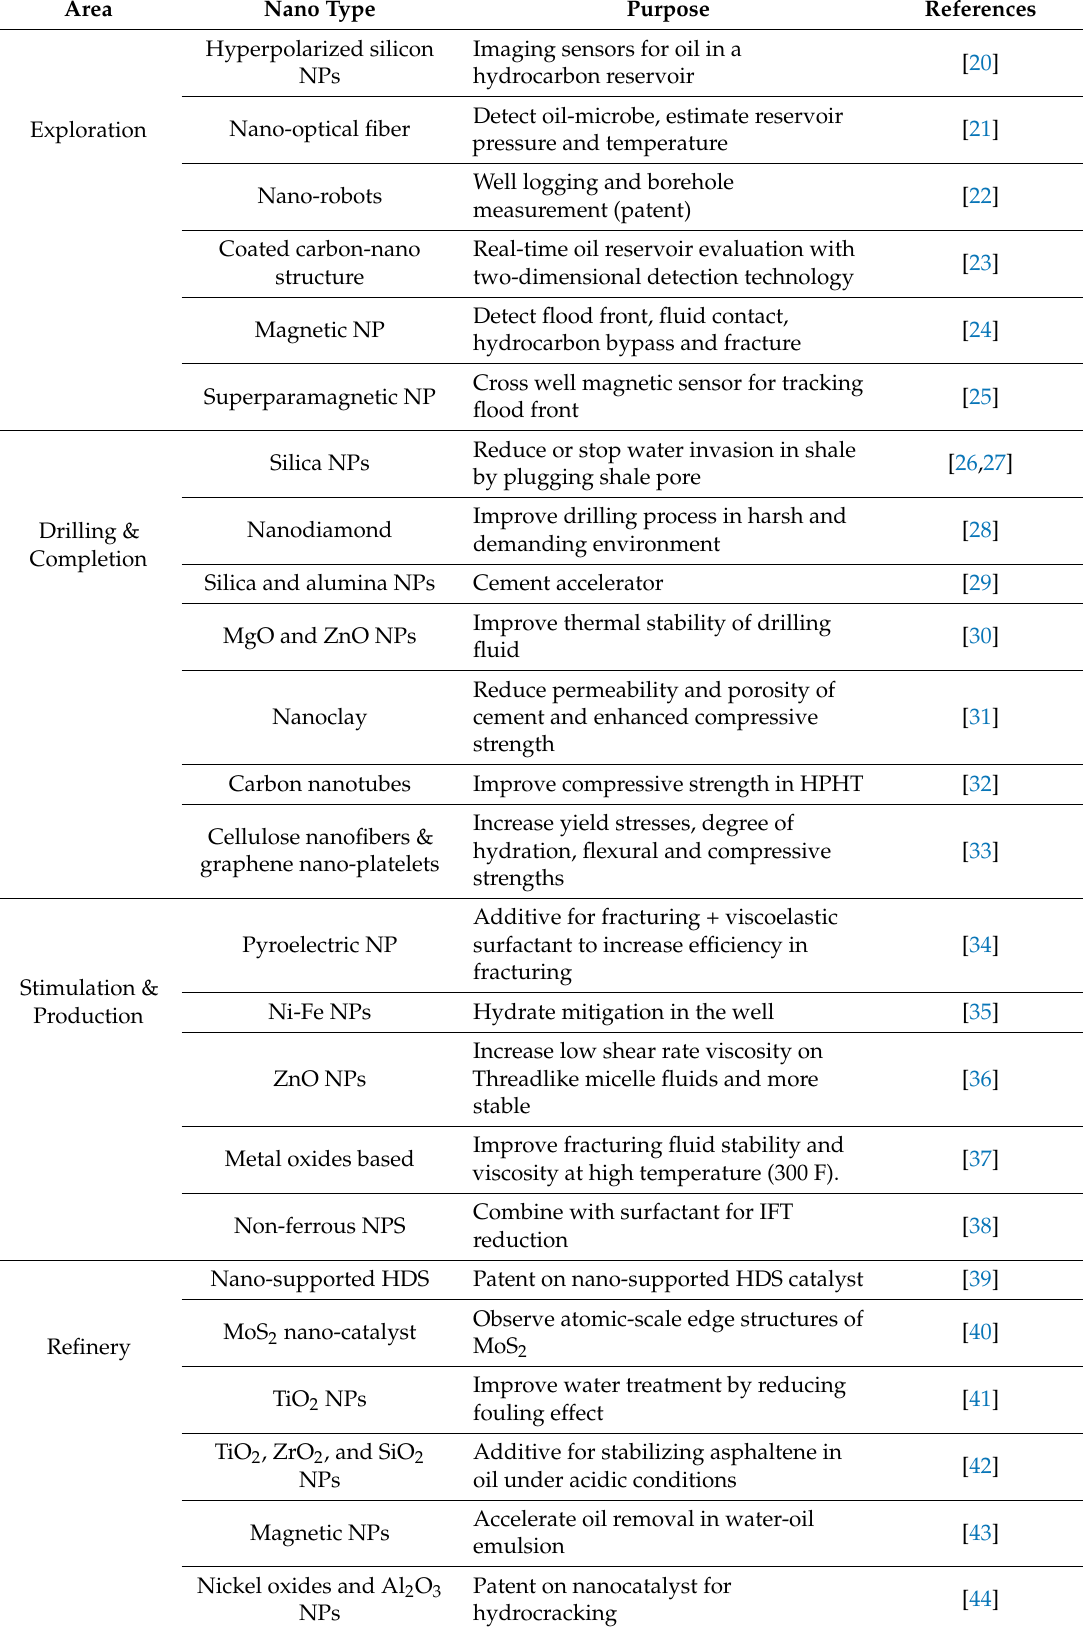
Table 1. Summary of the literature